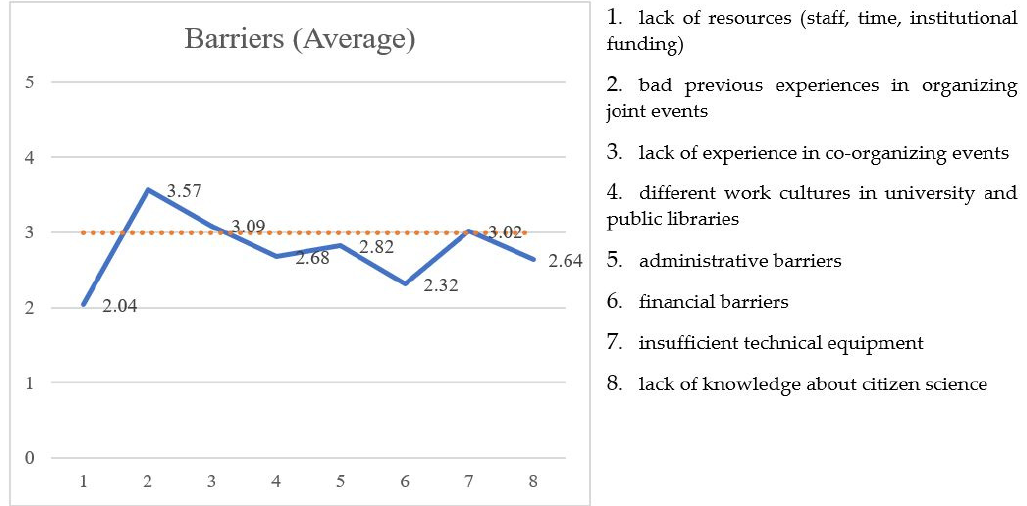
Figure 2. Average score (1 strongly agree; 5 completely disagree).